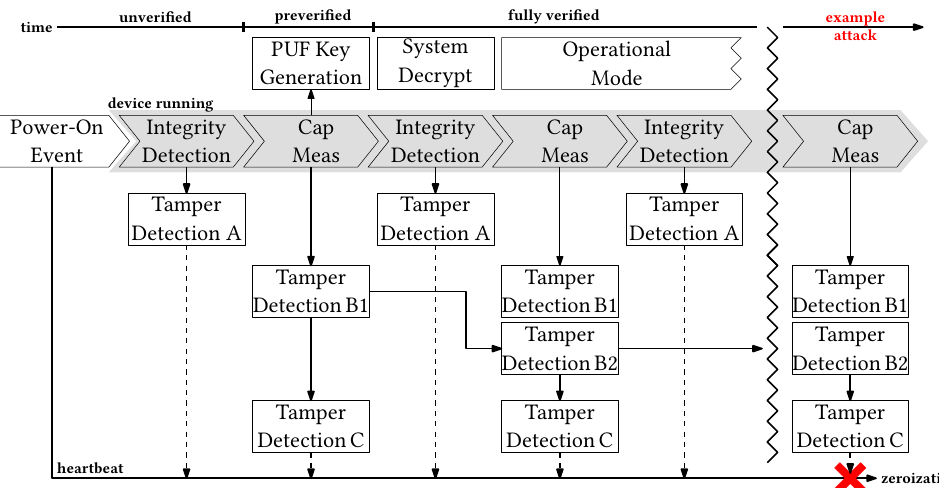
Figure 10: Secure boot process with intertwined security mechanisms, i.e., integrity detection and capacitance measurements. Attacks are detected shortly after power-on by either integrity detection or PUF key generation. Attacks during runtime are detected by the tamper detection (TD) mechanisms A, B1, B2 and